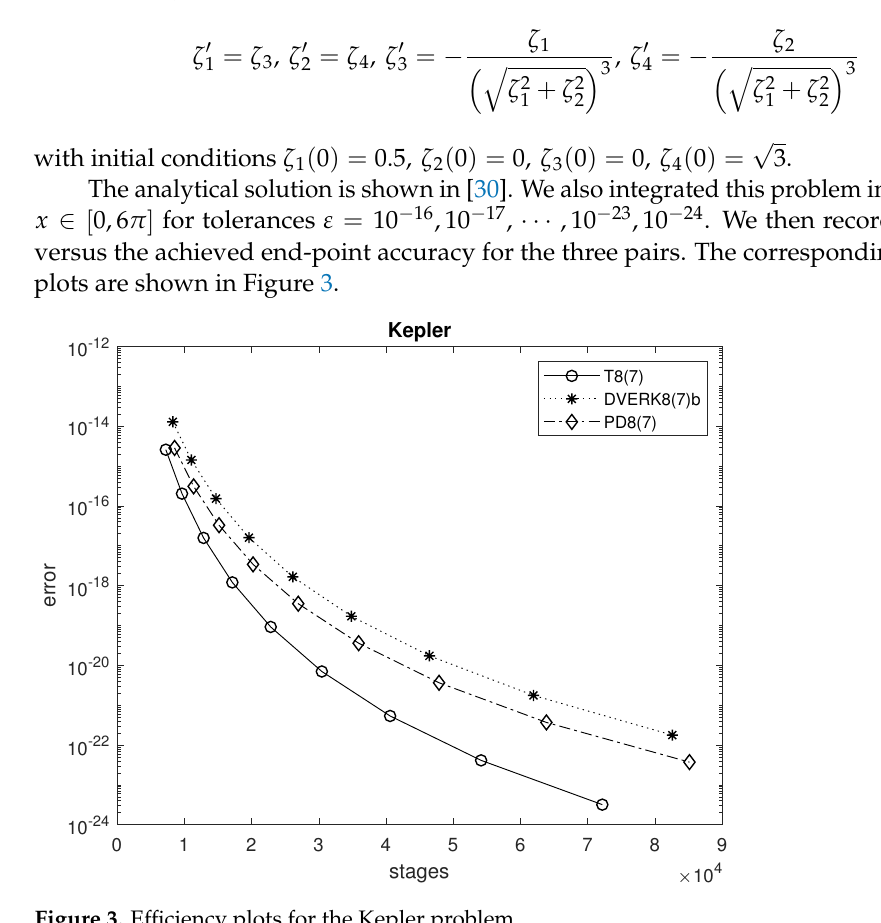
Figure 3. Efficiency plots for the Kepler